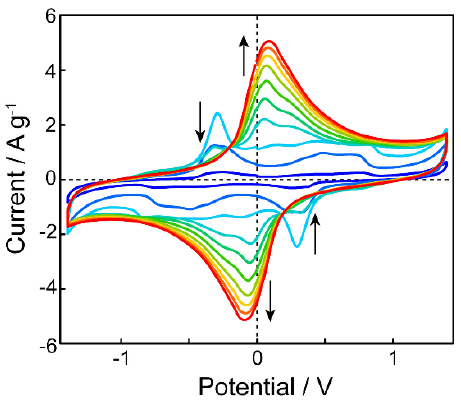
Figure 7. CV curves of a two-electrode cell of the mixture (GO + An + H 2 SO 4 ) at 100 mV s − 1 .